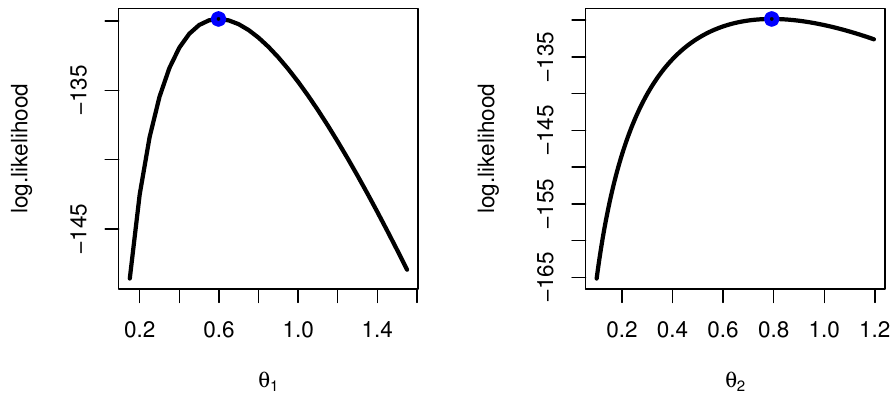
Figure 4. Profile likelihood for parameter estimation by RSS method for banking